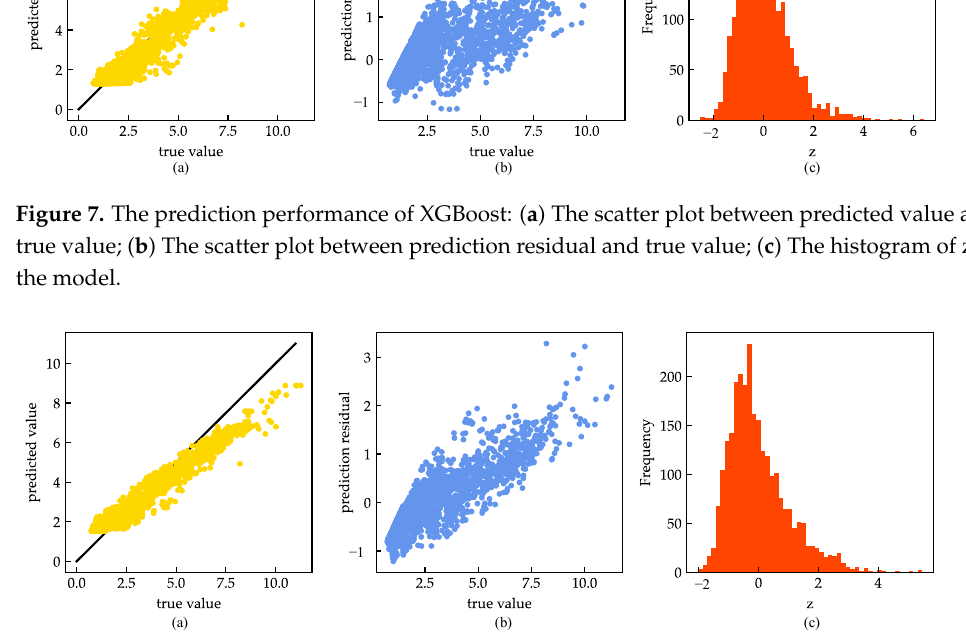
Figure 9. The prediction performance of RF: ( a ) The scatter plot between predicted value and true value; ( b ) The scatter plot between prediction residual and true value; ( c ) The histogram of z in the model.